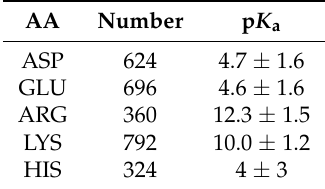
Table 2. Number an average p K a values of titrable amino acids of